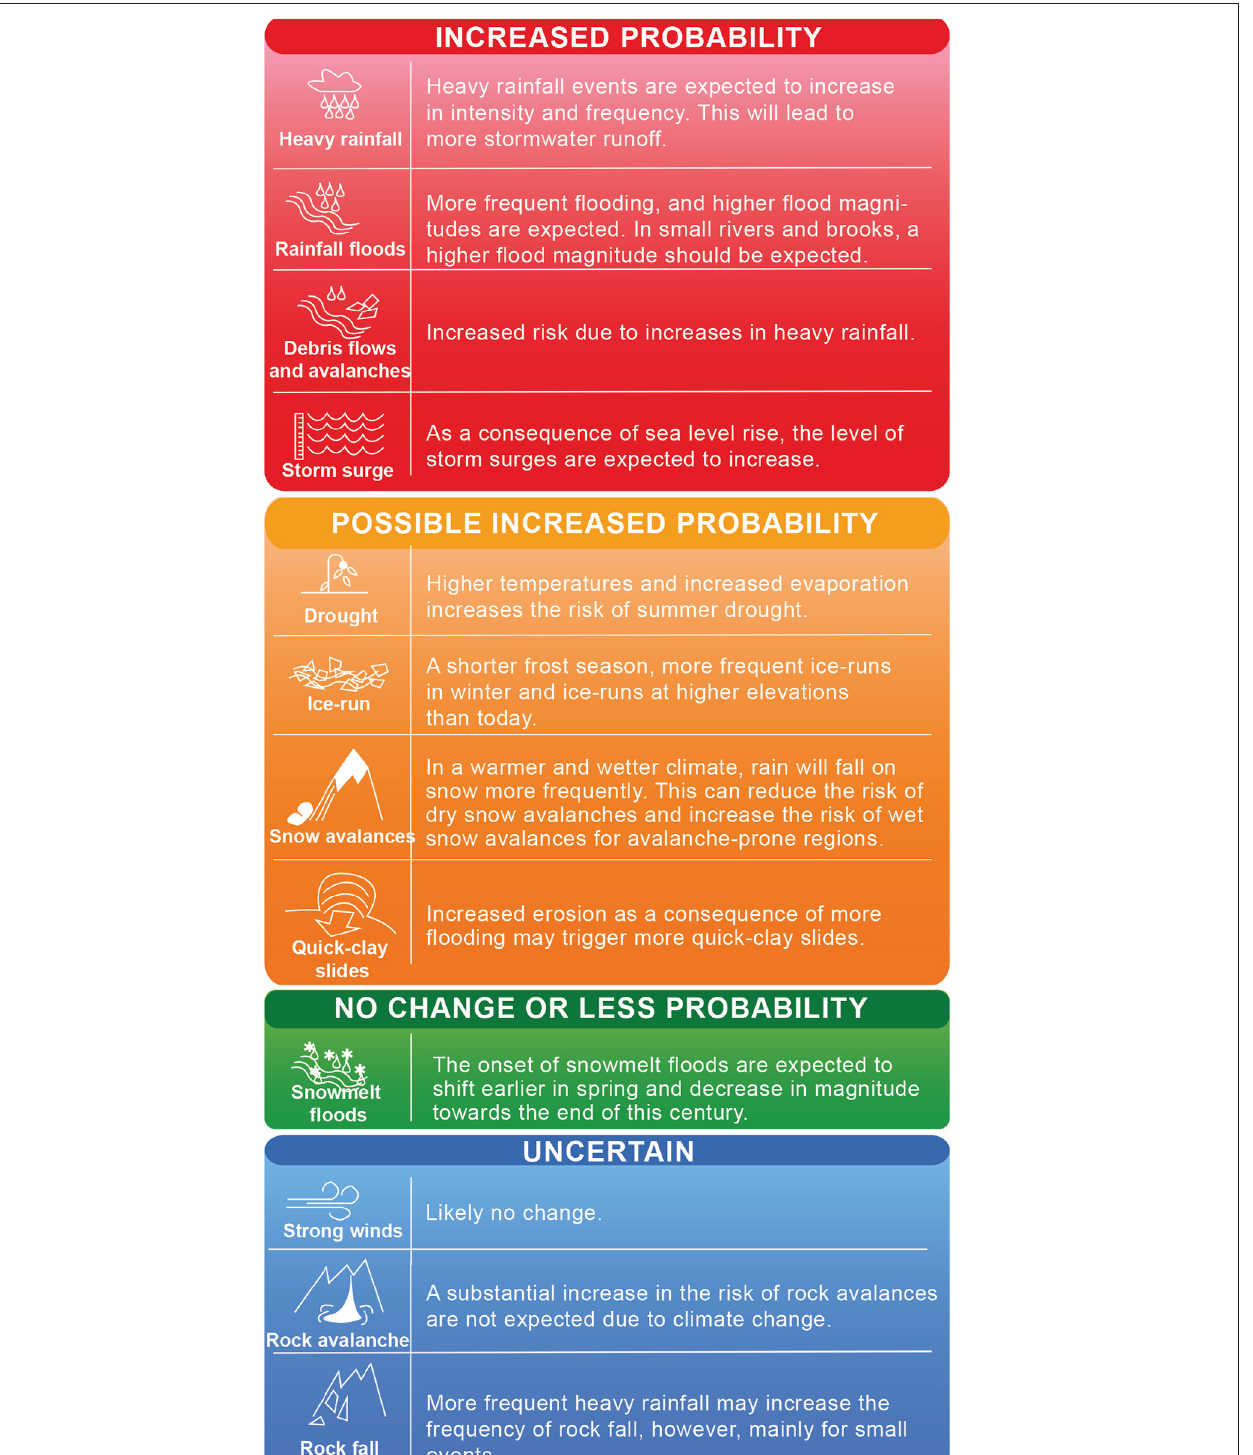
Frontiers in Climate |